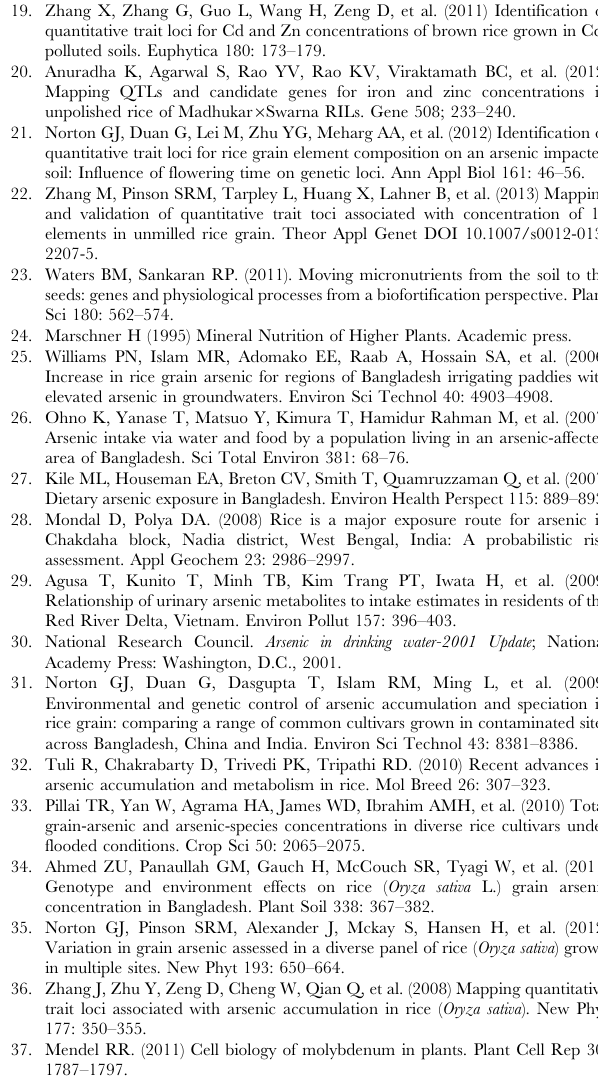
Figure S1 Correlation for elements at the Arkansas field site across both years. (A) copper P , 0.001, r= 0.407; (B) zinc P , 0.001, r=0.630; (C) arsenic P , 0.001, r= 0.407; (D) molyb- denum P , 0.001, r=0.555. Table S1 Elemental concentrations within each sub- population at the five field experiments. Table S2 Mean monthly temperatures ( u C) and total rainfall for the regions where field experiments were conducted (from www.worldweatheronline.com ). Table S3 List of significant SNPs associated with the accumulation of arsenic within rice grains. Table S4 List of significant SNPs associated with the accumulation of copper within rice grains.